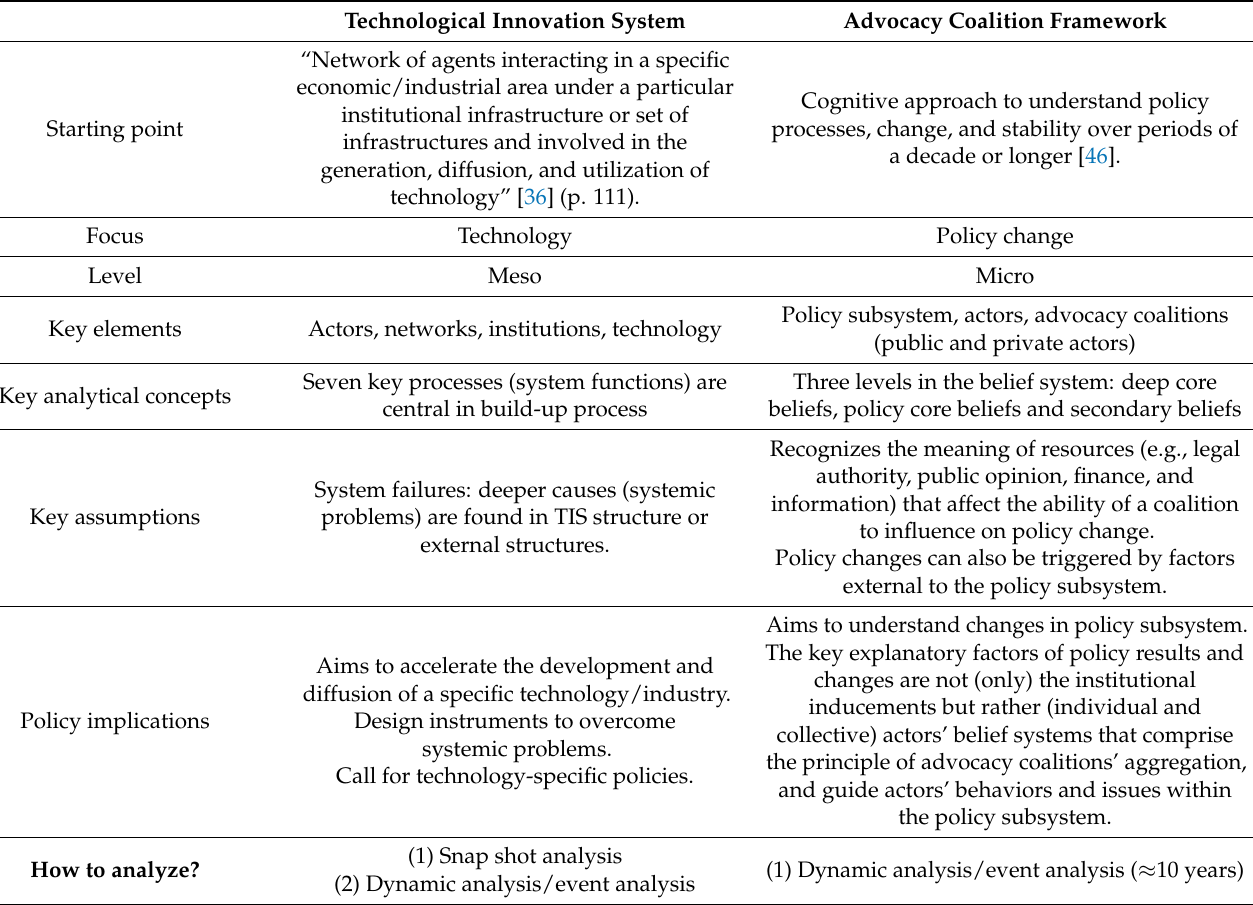
Table 1. Comparison of the ACF and TIS frameworks. This method of comparing the frameworks was inspired by Markard et al.